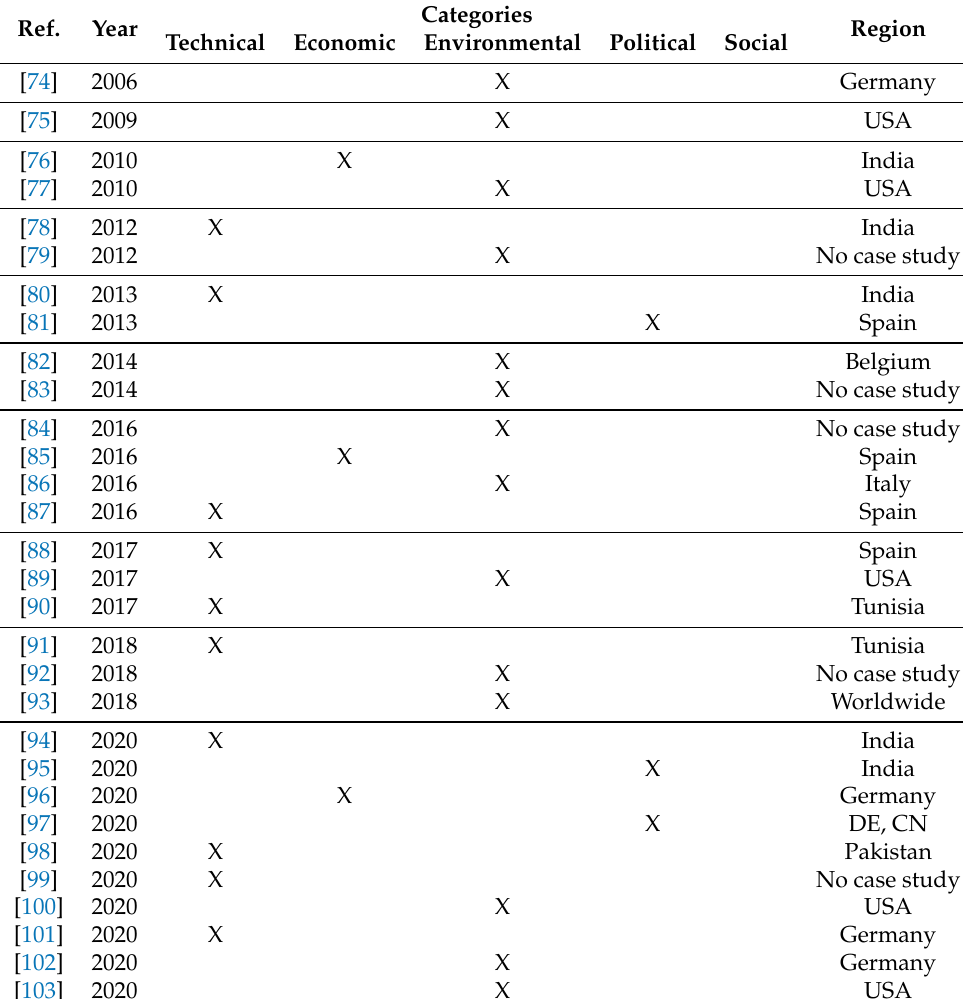
Table 3. Contributions with a single category in onshore wind repowering methodologies. Period (2000–2021).